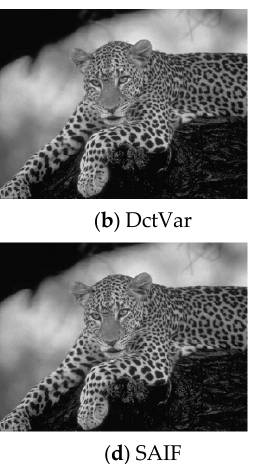
Figure 12. The fusion result of the lab image.